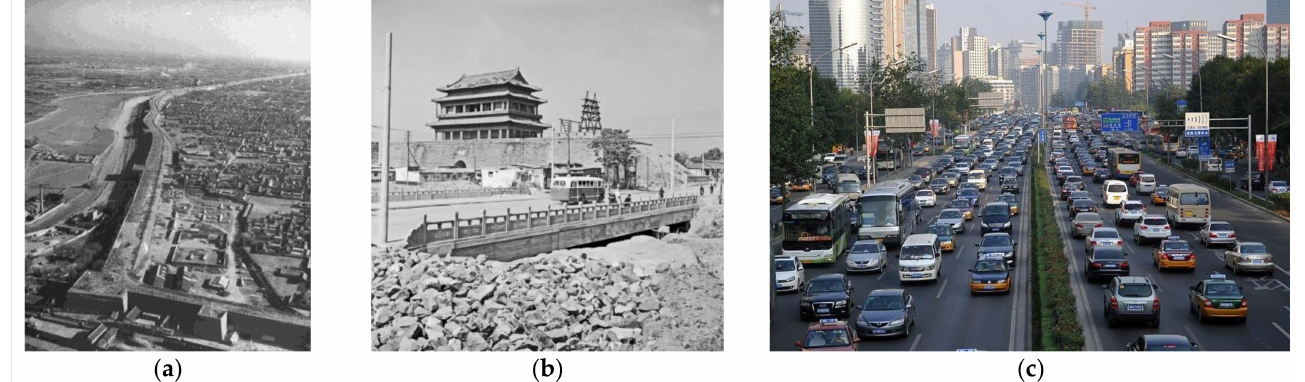
Figure 1. City walls of Beijing in different periods: ( a ) the complete city wall in the past; ( b ) the city wall being demolished; ( c ) the Second Ring Road built on the original